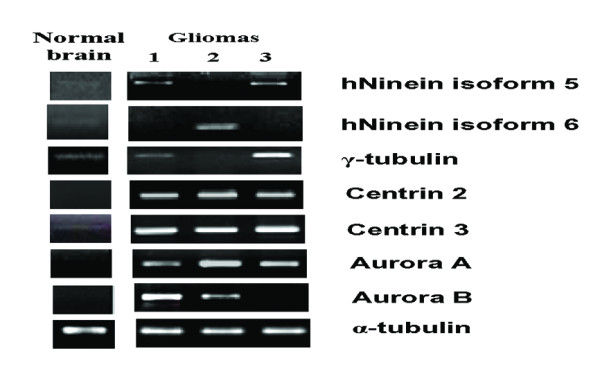
RT-PCR analysis of hNinein isoforms 5 and 6, γ-tubulin, Aurora A, and Aurora B in gliomas. α-tubulin expression was used as an internal loading control. Data from three gliomas are shown compared to a normal human brain sample. Data shown are representative of at least three independent experiments per glioma.